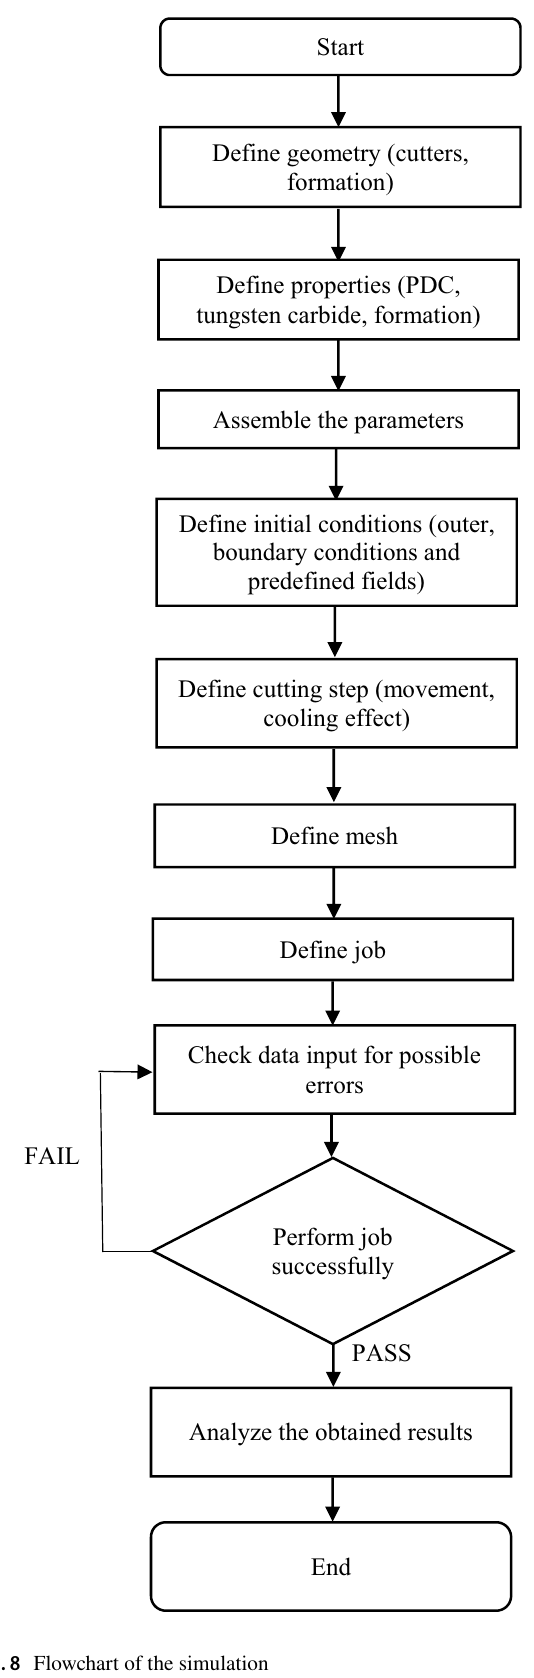
Fig. 8 Flowchart of the